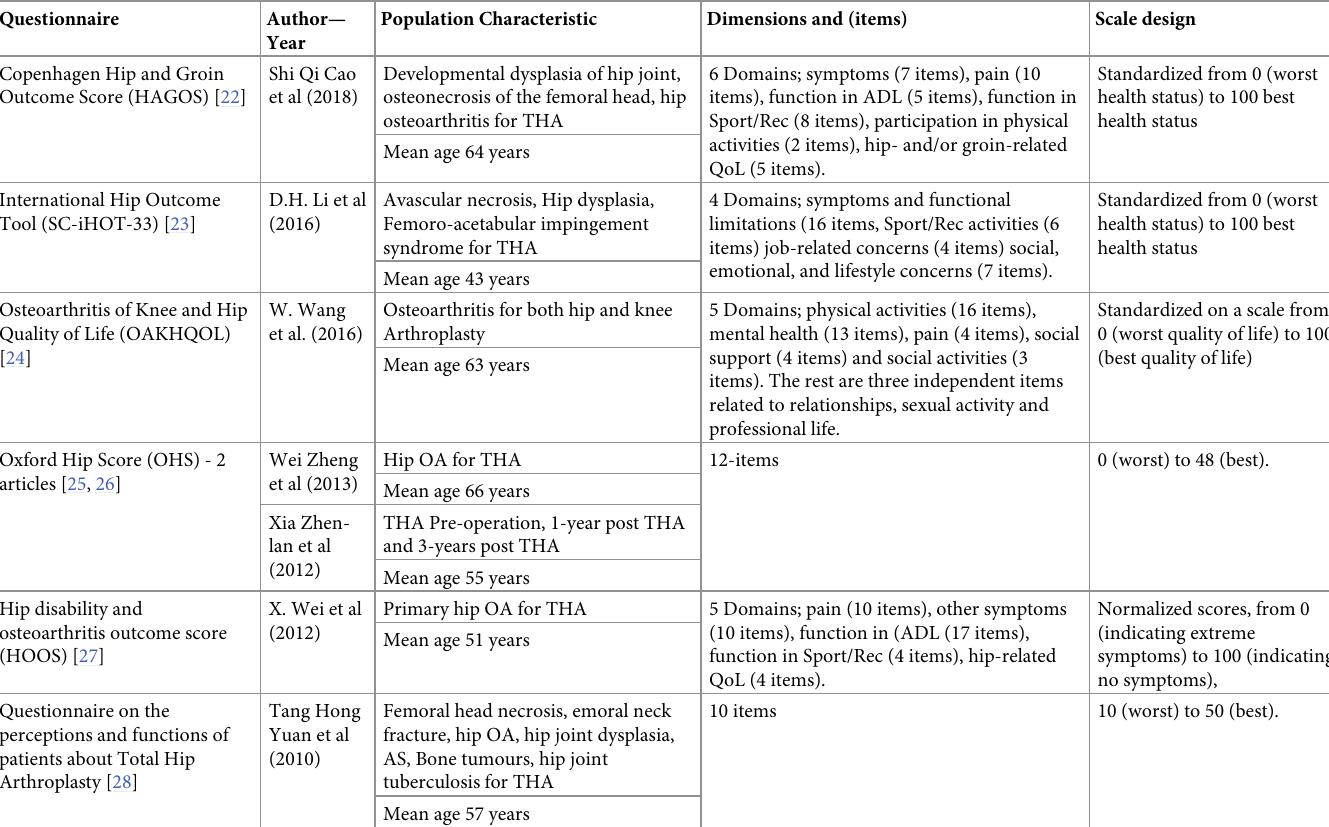
Table 1. General characteristics of Chinese cross-cultural adaptation and translation of hip PROMs.